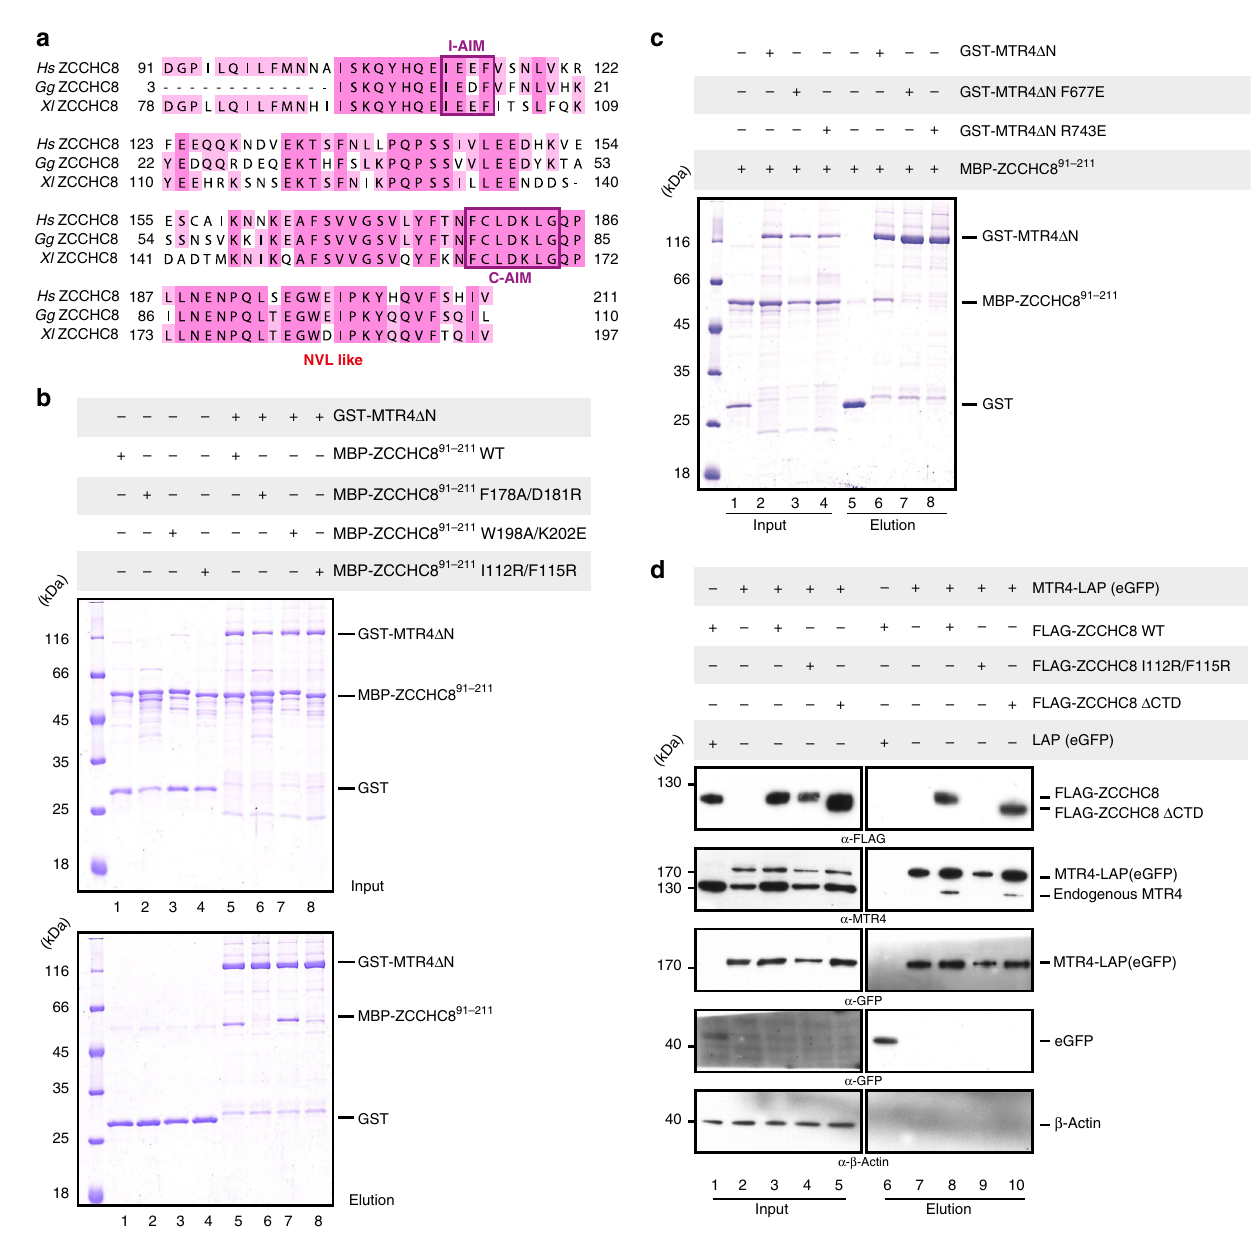
Fig. 5 Analysis of the ZCCHC8-MTR4 KOW complex by site directed mutagenesis. a Sequence alignment of the region between the predicted coiled coil domain and the zinc fi nger of ZCCHC8 from representative metazoan species, Homo sapiens ( Hs ), Gallus gallus ( Gg ), Xenopus laevis ( Xl ), highlighting NVL- like region (red), Nop53-like AIM (C-AIM) and ZCCHC8 speci fi c I-AIM (purple boxes). The sequences were obtained from the UniProt database and aligned using the T-coffee server 59 . b Protein co-precipitations by pull down assays testing ZCCHC8 91 – 211 mutants for MTR4 Δ N binding ability. GST- tagged MTR4 Δ N was incubated with either ZCCHC8 91 – 211 WT or mutants before co-precipitation with glutathione sepharose beads. A total of 3% of the input (top) and 30% of the eluates (bottom) were analyzed on 12% SDS-PAGE gels and visualized by staining with coomassie brilliant blue. c Protein co- precipitations by pull down assays testing MTR4 Δ N mutants for their ZCCHC8 91 – 211 binding ability. GST-tagged MTR4 Δ N (WT or mutant variants) were incubated with MBP-ZCCHC8 91 – 211 before co-precipitation with glutathione sepharose beads. A total of 3% of the input (lanes, 1 – 4) and 30% of the eluates (5 – 8) were analyzed on 12% SDS-PAGE gels and visualized by staining with coomassie brilliant blue. d Cellular co-IP assay. FLAG-tagged ZCCHC8 constructs (WT/IF mutant/CTD deletion) were transiently expressed in cells stably expressing MTR4-LAP. After precipitation of MTR4 taking advantage of the LAP tag, a total of 0.5% of the input (left) and 8.0% of the eluates (right) were analyzed on 4 – 12% SDS-PAGE gel followed by western blotting analysis. The primary antibody used is indicated below the